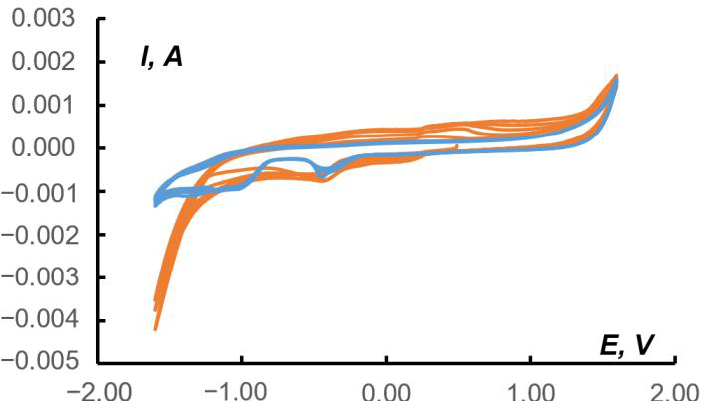
Figure 10. The CV data (first five cycles) for 0.0373 M HCOOH in 0.1 M Na 2 SO 4 aqueous solution (blue curves); CV data (first five cycles) for the paste electrode containing 1 after CO 2 exposure into the 0.1 M Na 2 SO 4 aqueous solution (orange curves). Potentials vs. saturated Ag/AgCl reference electrode. Scan rate 10 mV/s.